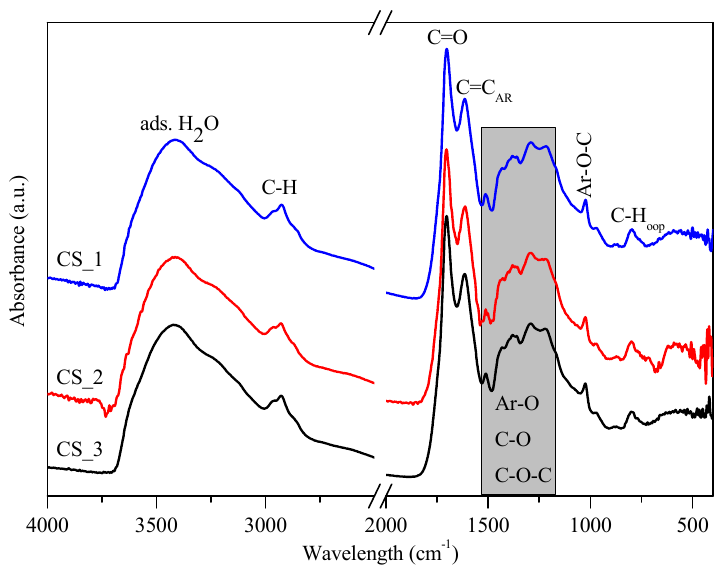
Figure 3. IR spectra of carbon spheres purified with increasing amounts of acetone (CS_1 < CS_2 < CS_3, respectively) by membrane filtration.